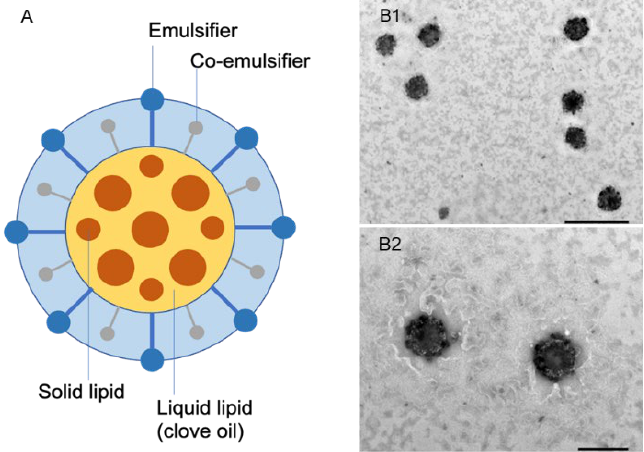
Figure 2. The schematic representation of CO-NLC ( A ). The morphology of CO-NLCs visualized by transmission electron microscopy ( B1 , B2 ). Scale bar: 200 nm ( B1 ) and 100 nm ( B2 ), respectively. The CO-NLCs were stable for up to 3 months of storage in different conditions (30 °C/60% RH and 40 °C/75% RH) (Figure S2) . The CO-NLCs particle size (Figure 3A) and zeta potential (Figure 3B) for 1, 2, and 3 months did not differ (p < 0.05) compared to the initial size and zeta potential in either condition.